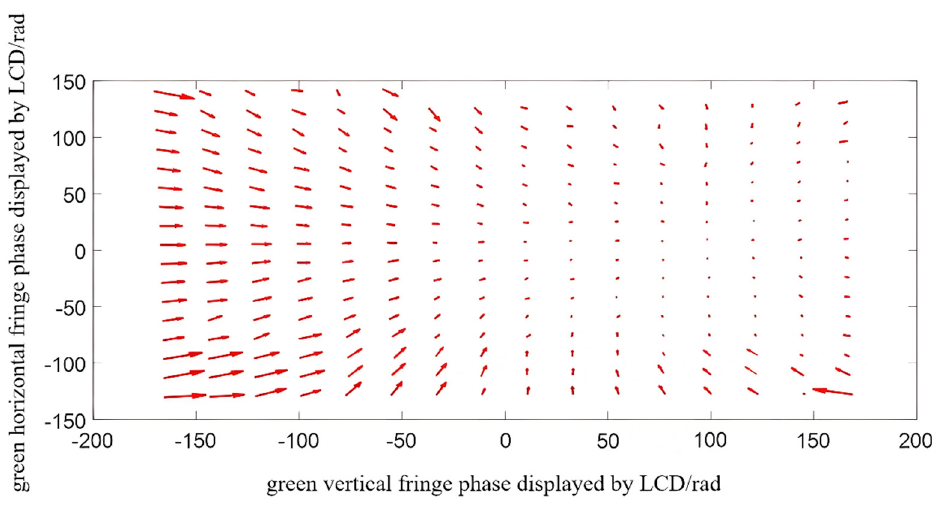
Figure 11. Schematic diagram of the chromatic aberration vector of the red and green channels.